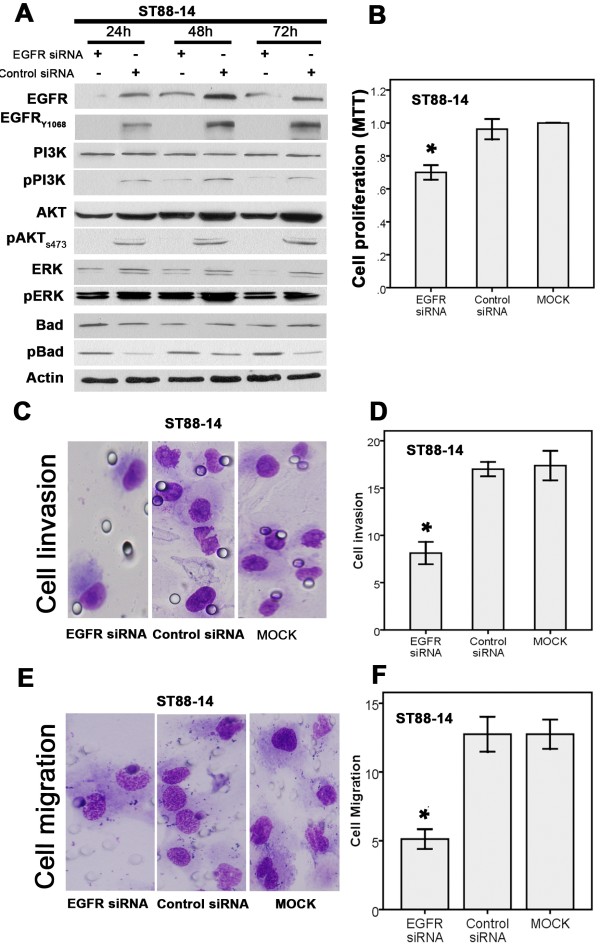
Down-regulation of EGFR by EGFR siRNA in ST88-14 MPNST cells significantly decreased tumor cell proliferation, invasion, and migration by blocking PI3K/AKT and MAPK pathways. (A)EGFR siRNA decreased EGFR expression and activation. Activated forms of PI3K/AKT and MAPK pathway factors decreased with EGFR inhibition. (B)EGFR siRNA significantly decreased tumor cell proliferation compared with the nonspecific control siRNA. (C, D)EGFR siRNA significantly decreased tumor cell invasion compared with nonspecific control siRNA: cell invasion (C) and cell counts (D). (E, F)EGFR siRNA significantly decreased tumor cell migration compared with nonspecific control siRNA: cell migration (E) and cell counts (F). * indicate P-values <0.05.